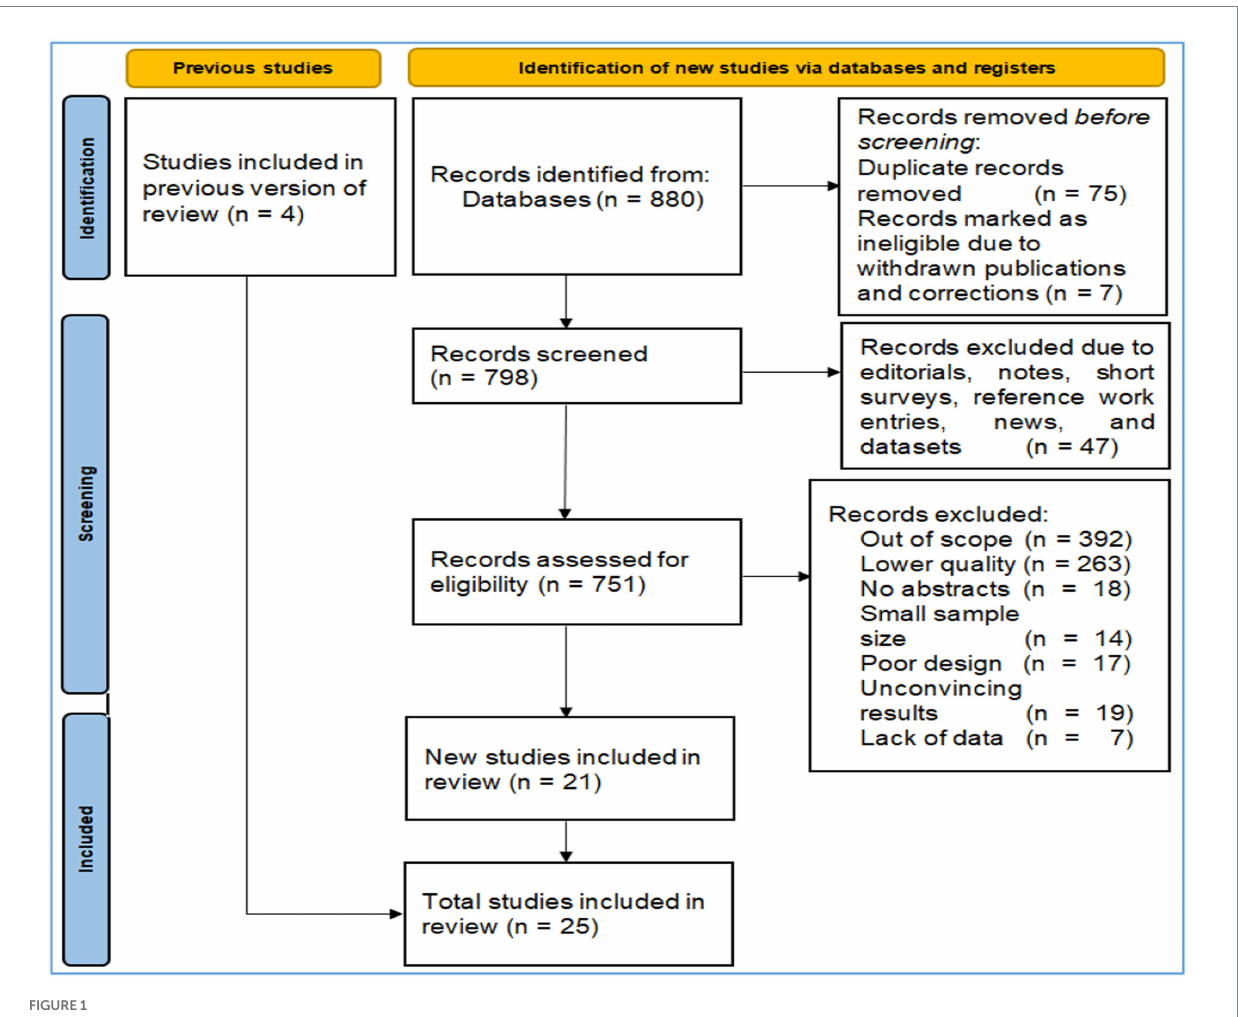
FIGURE 1 A flow chart of literature selection based on inclusion and exclusion